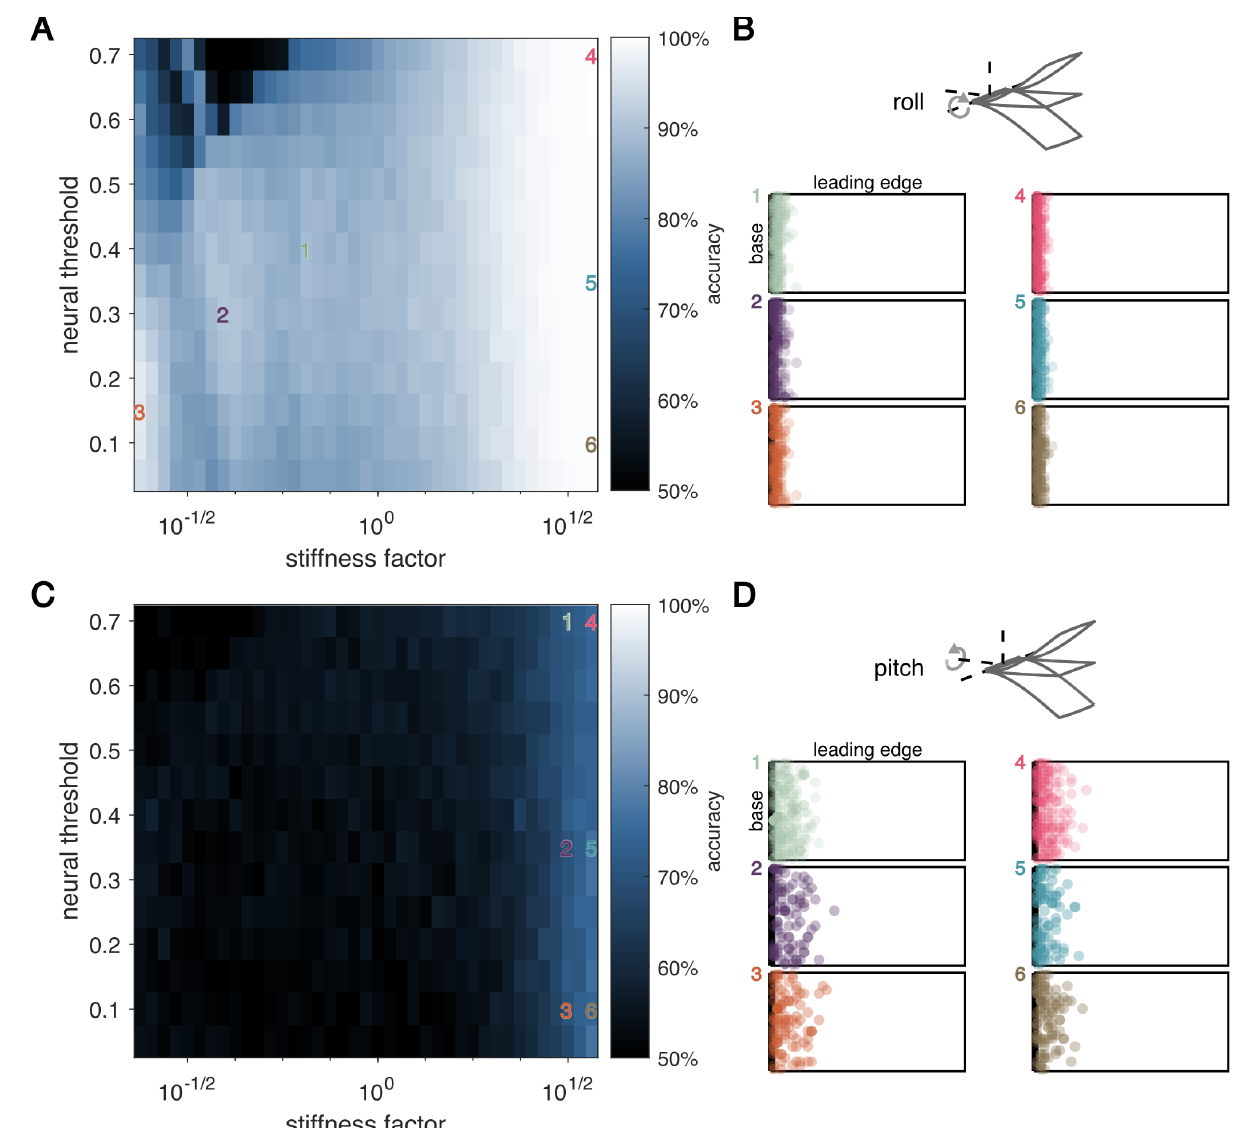
Fig 4. For detecting rotation in the roll and pitch axes, sensor locations do not depend on stiffness or neural encoding properties. A,C: Accuracy as a function of neural threshold and wing stiffness for roll and pitch, respectively. B,D: Optimal sensor locations of 10 best sensors, overlaid for 20 different data sets. Neural threshold and wing stiffness of each panel are indicated by the corresponding colored number in A. Top : Schematics indicate the axis of